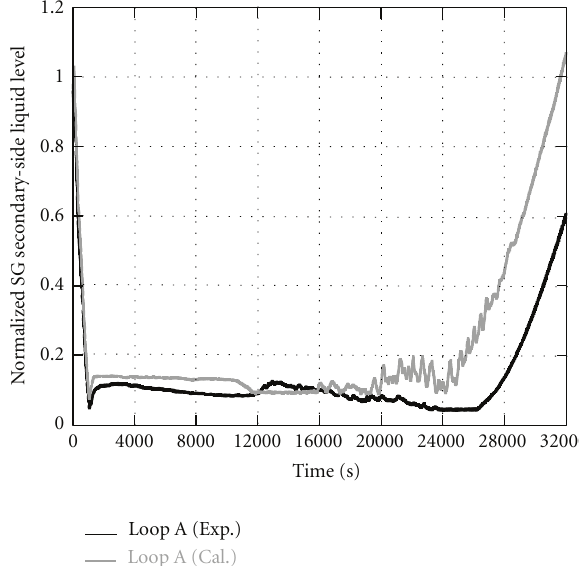
Figure 5: LSTF core power curve pre-determined through PWR analysis, being compared with LSTF core power decay curve in case of LOFW with scram.